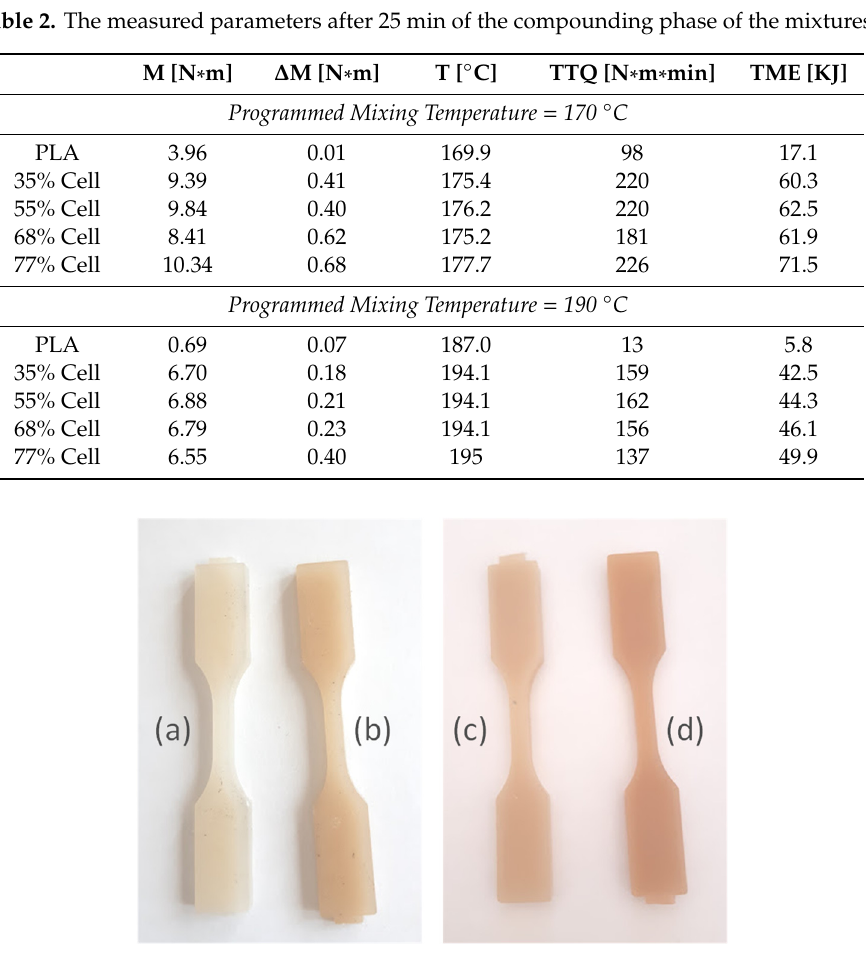
Figure 5. Representative processed samples of: ( a ) PLA after 10 min of mixing at 170 °C; ( b ) PLA after 25 min of mixing at 190 °C; ( c ) PLA/Cellulose at 35 vol./vol.% after 10 min of mixing at 170 °C; ( d ) PLA/cellulose at 35 vol./vol. % after 25 min of mixing at 190 °C.